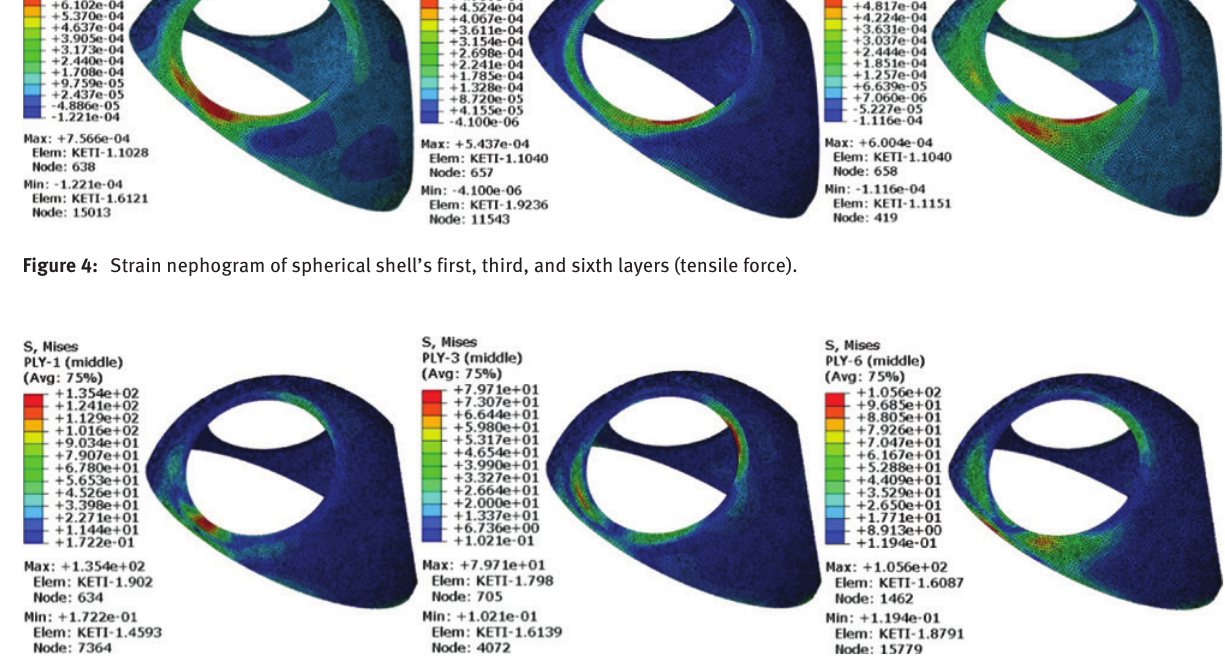
Figure 5: Stress nephogram of spherical shell’s first, third, and sixth layers (compression force).